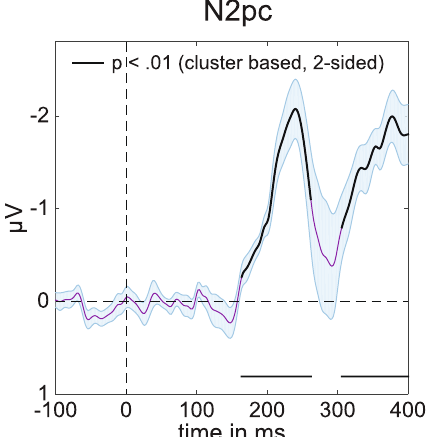
Figure 3. Average N2pc for left and right targets in Experiment 1. Computed using PO7 and PO8 (see methods). Black lines have p < 0.01 using cluster based permutation testing, see main text for exact p-values. Shaded areas show + / − s.e.m. Peak at 240 ms.